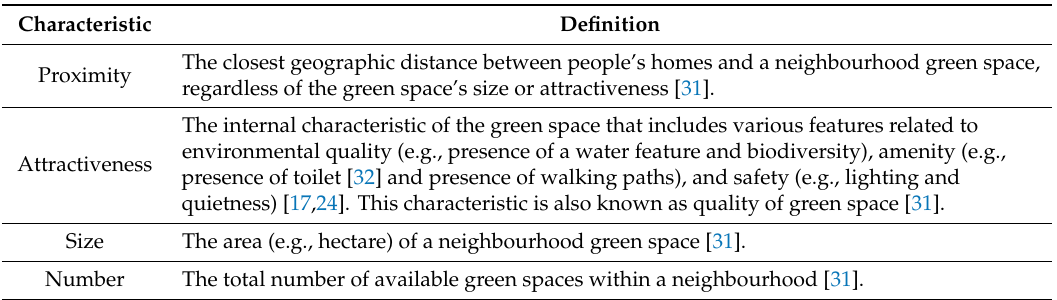
Table 1. Four neighbourhood green spaces